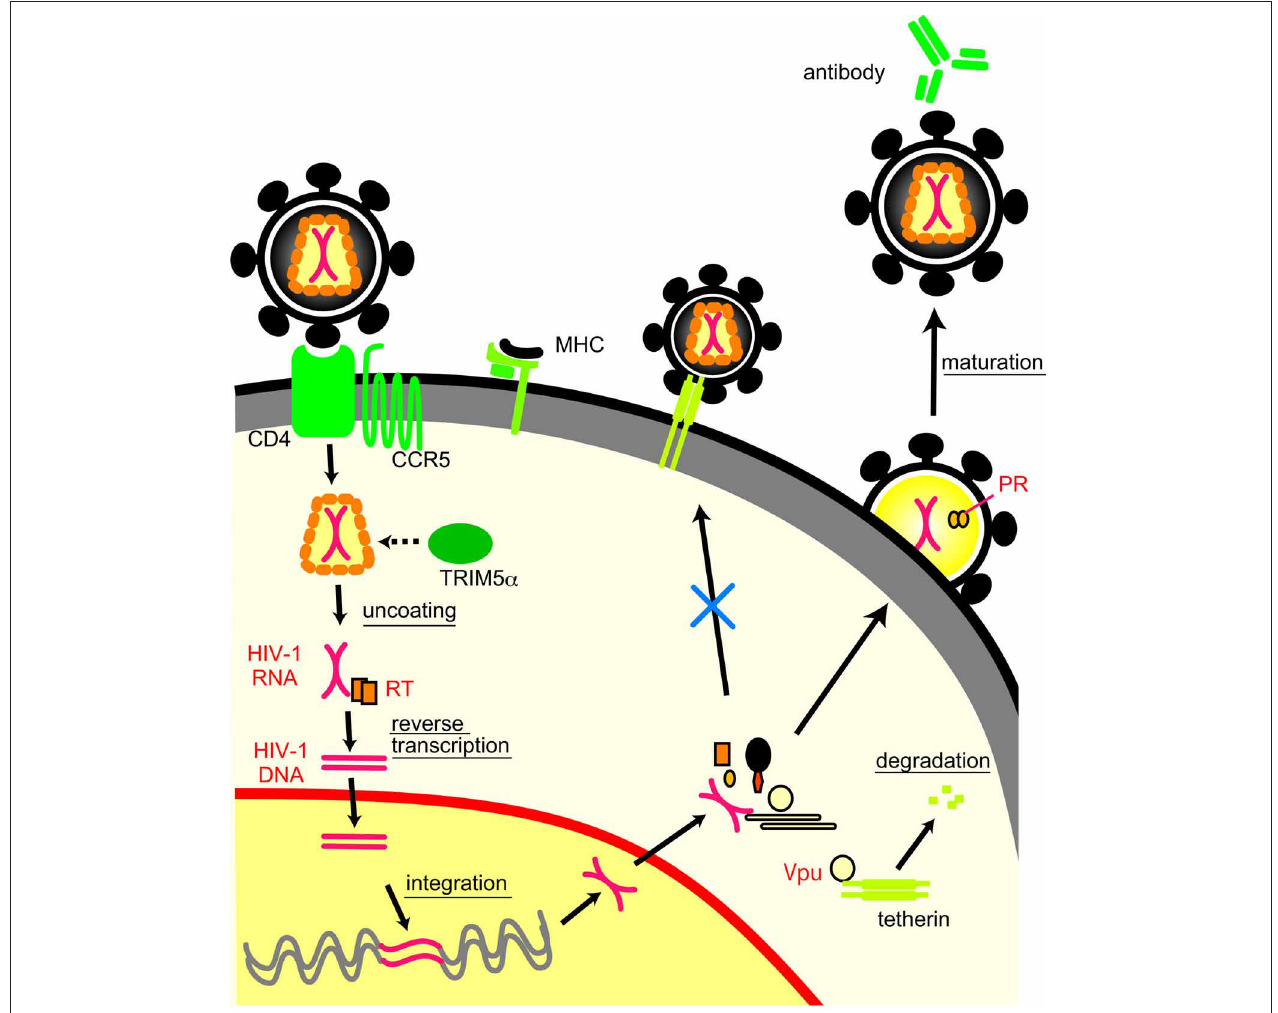
FIGURE 2 | Life cycle of HIV-1 and interactions between viral proteins and host immune molecules.